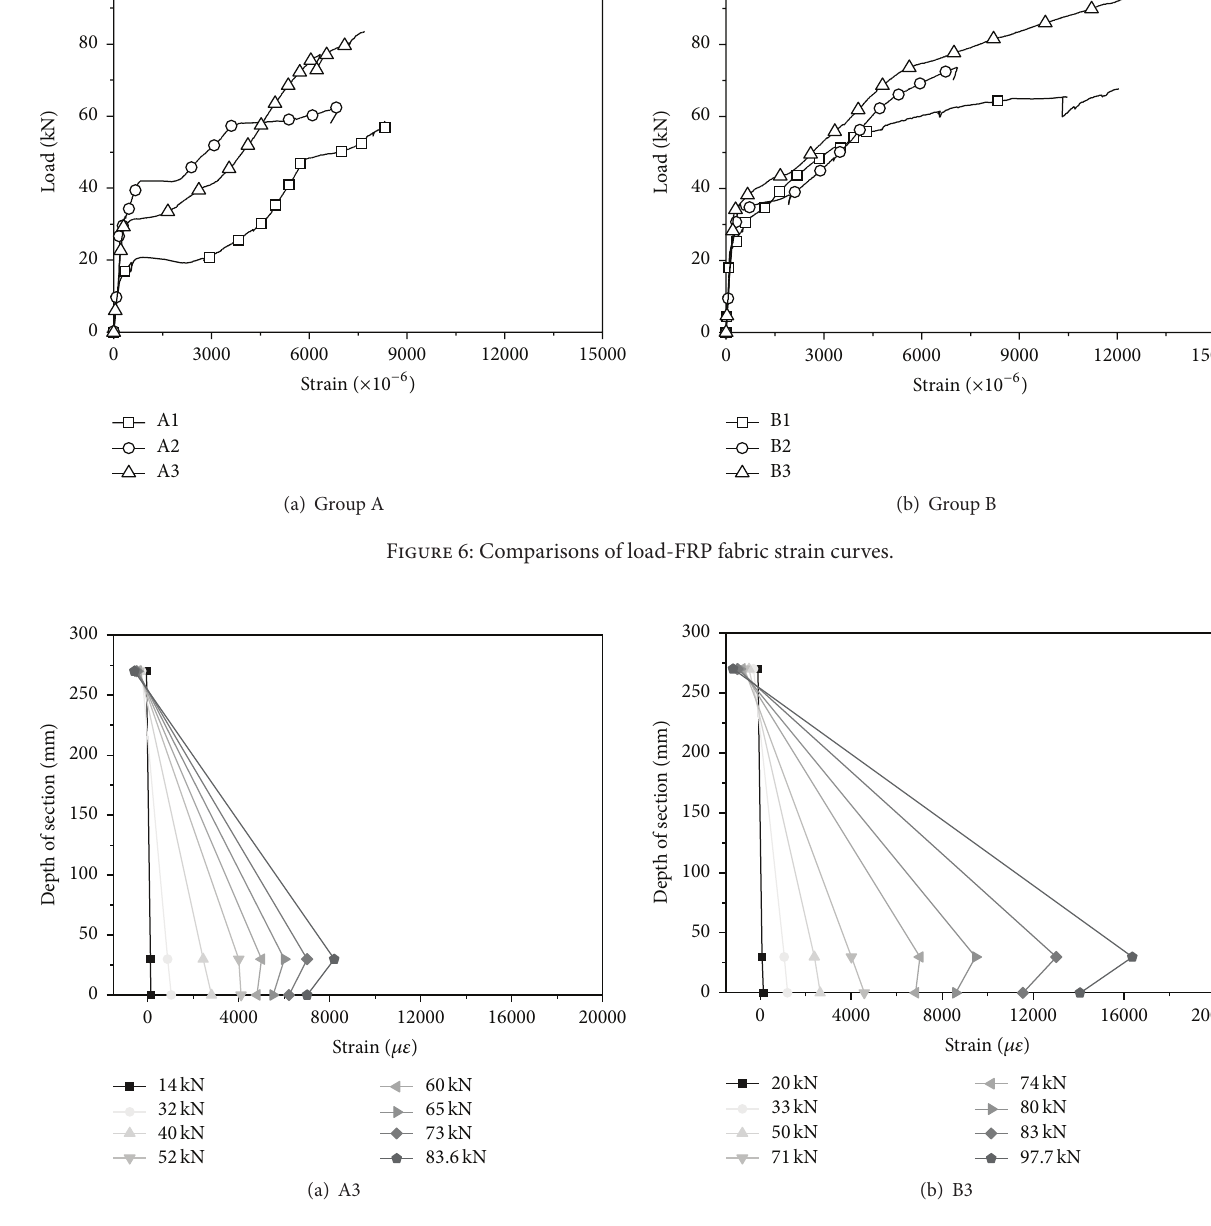
Figure 7: Strain distributions at a midspan